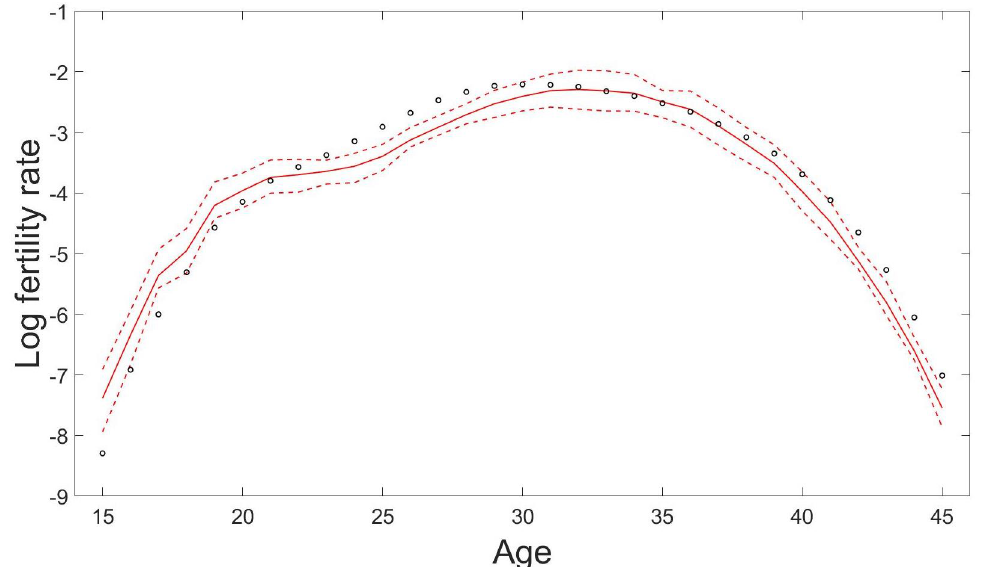
Figure 6. Predicted fertility curve from age 15 to age 45 with the 95% prediction intervals using the GPR model for the year 2016 based on the observations from the year 1947 to the year 2006 in Japan. The circles are the true log fertility rates, the solid line is the prediction, and the dashed lines are the 95% prediction